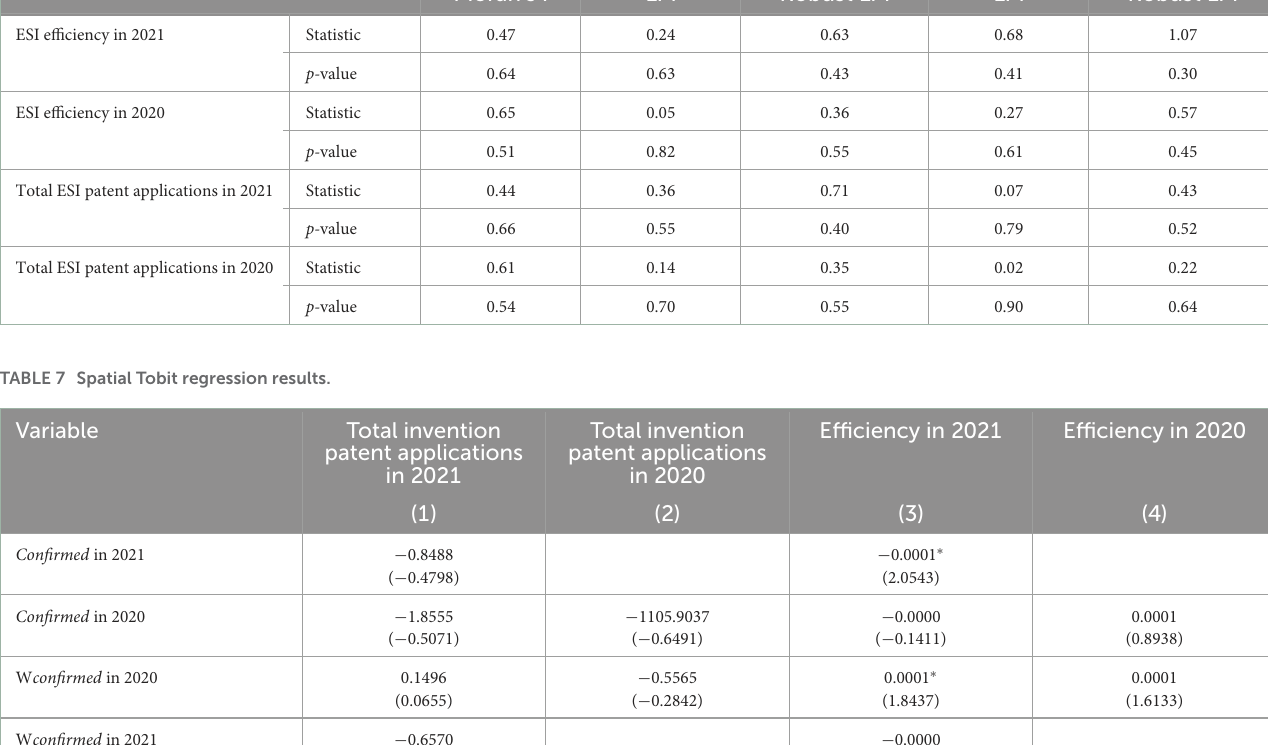
TABLE 6 Spatial measurement model selection.